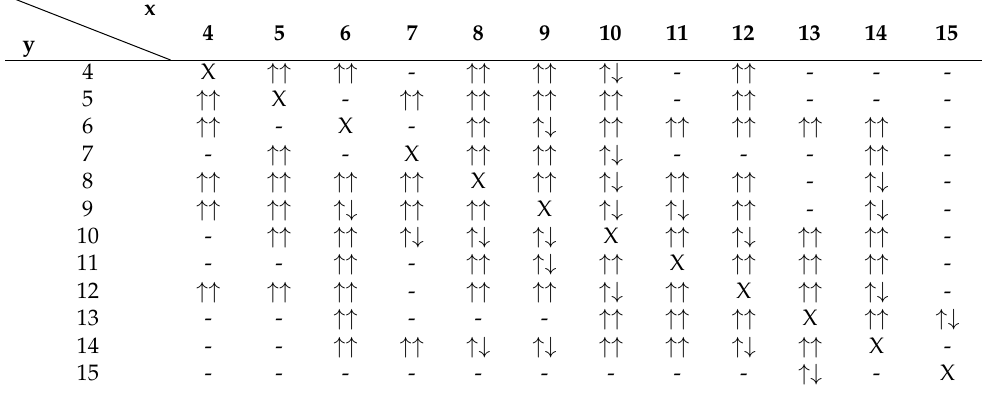
Table 1. Results of regression analysis: direction of changes in related indicators.